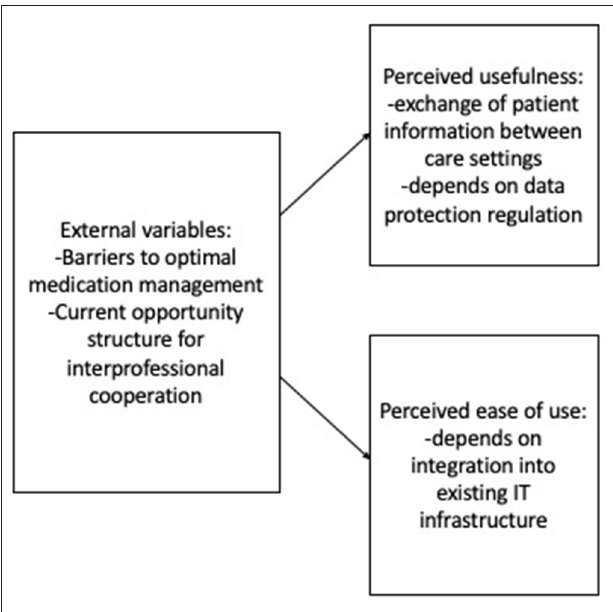
FIGURE 5 | Factors playing a role in technology acceptance (24, 25) for a digital tool for interprofessional